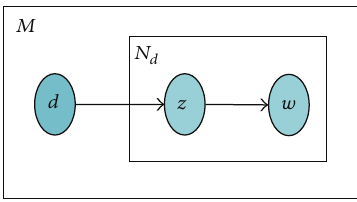
Figure 3: Graph model of SpLSA. Nodes represent random vari- ables. Shaded nodes are observed variables and unshaded ones are unseen variables. The plates stand for